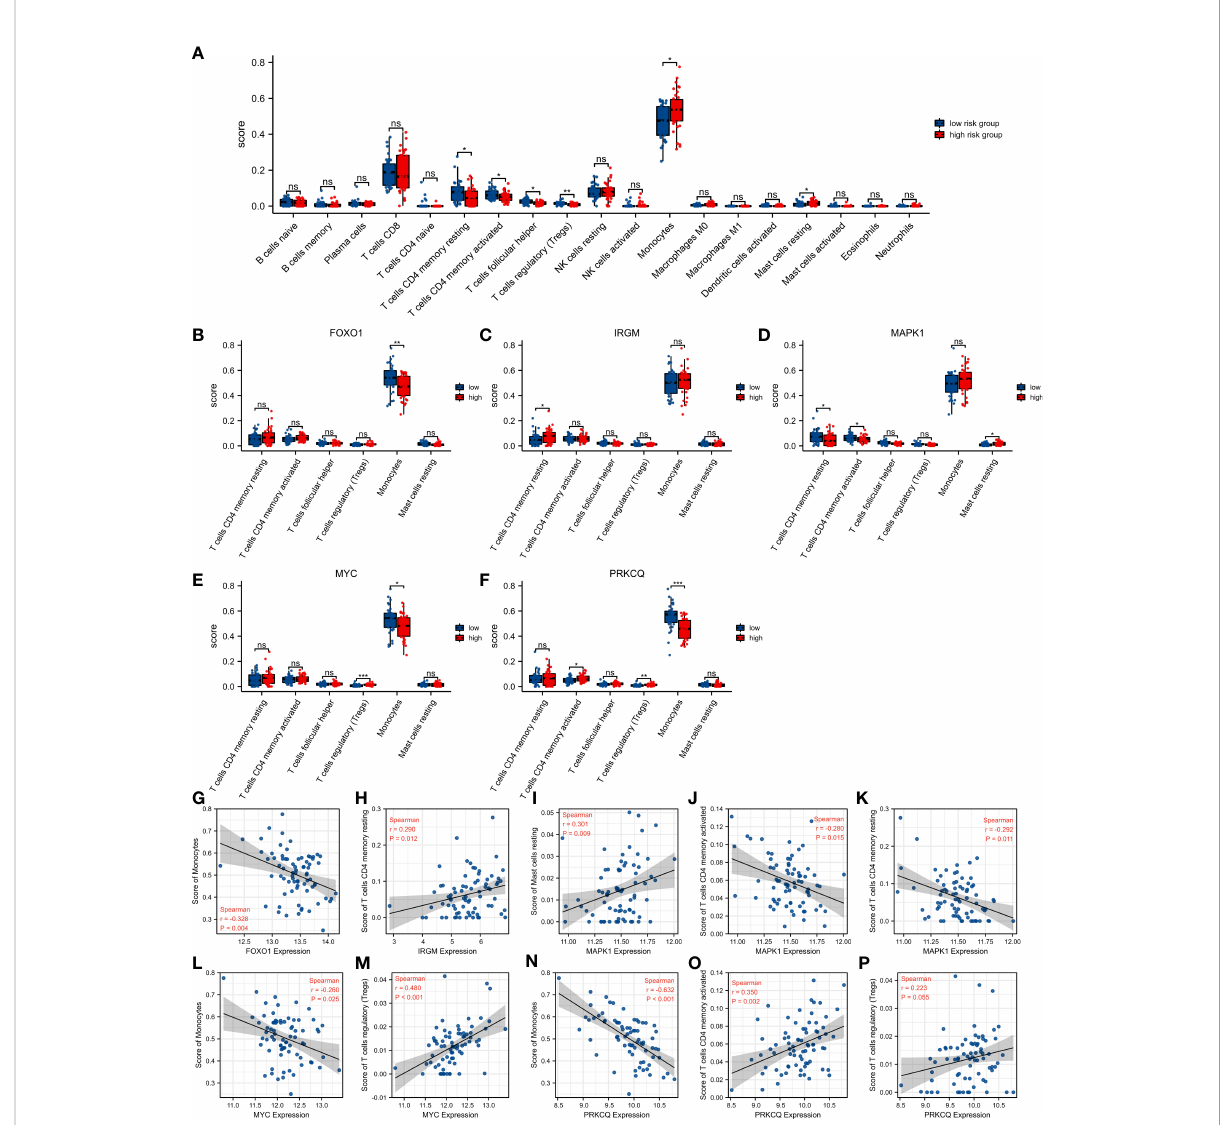
FIGURE 6 Relationship between autophagy-associated prognostic model and immune cell in fi ltration in IPF. (A) The difference of 22 immune cells between the high-risk score group and the low-risk score group. (B – F) Comparison of in fi ltration levels of 6 immune cells according to FOXO1 (B) , IRGM (C) , MAPK1 (D) , MYC (E) , and PRKCQ (F) expression levels. (G – P) The correlation analysis between autophagy-associated genes and speci fi c immune cells. *p< 0.05, **p< 0.01, ***p< 0.001, and ns, no signi fi cance